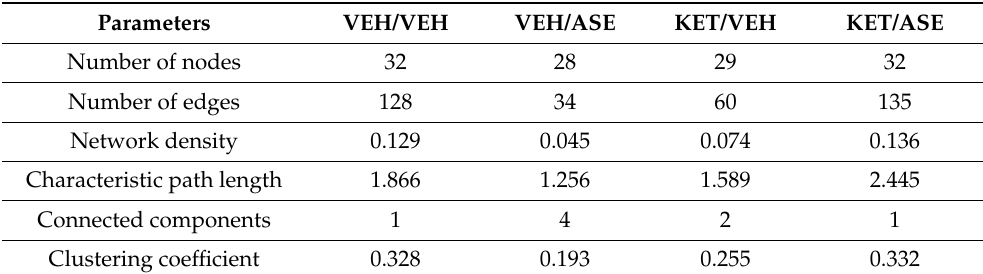
Table 5. Discrete parameters are reported for each network after retaining only significant ( p -value < 0.05) correlations.